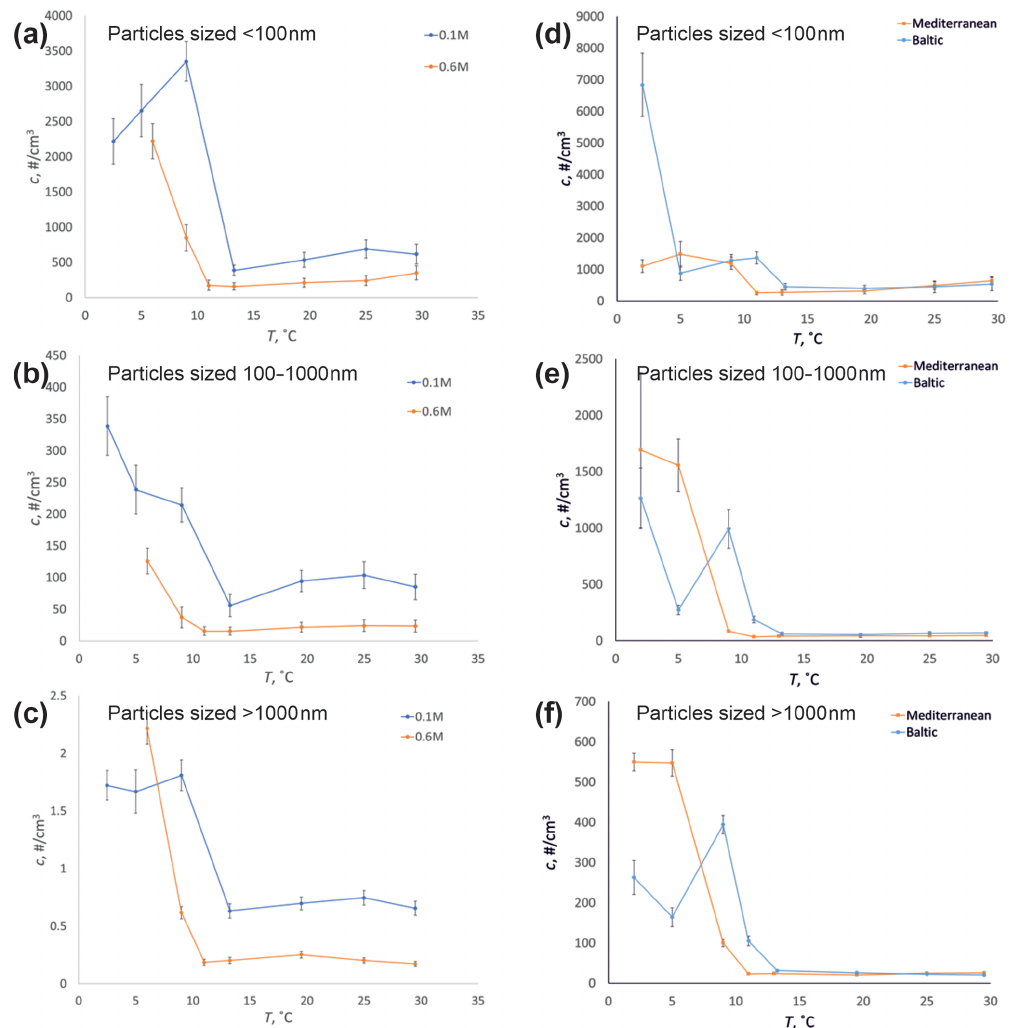
Figure 11. Temperature dependence on particle concentration for aerosols sized below 100nm (a, d) , from 100 to 1000nm (b, e) , and above 1000nm (c, f) for 0.1 and 0.6M NaCl-solutions (a–c) and the water of the Mediterranean and Baltic seas (d–f) bubbled at 0.8Lmin − 1